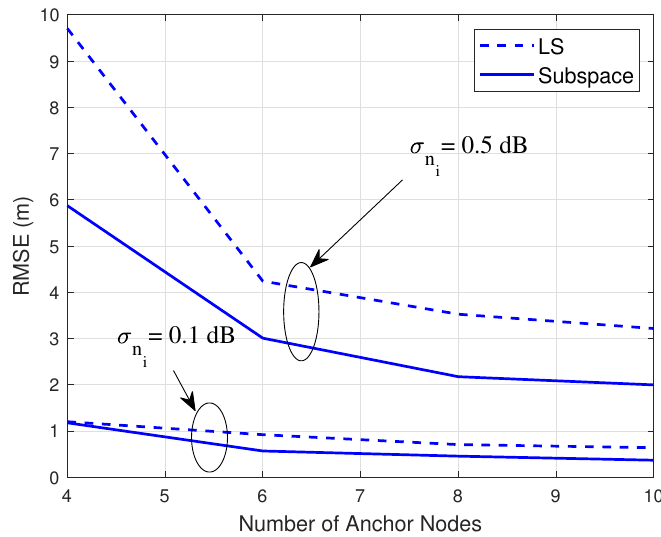
Figure 1. Comparison of the subspace and least square (LS) solutions.